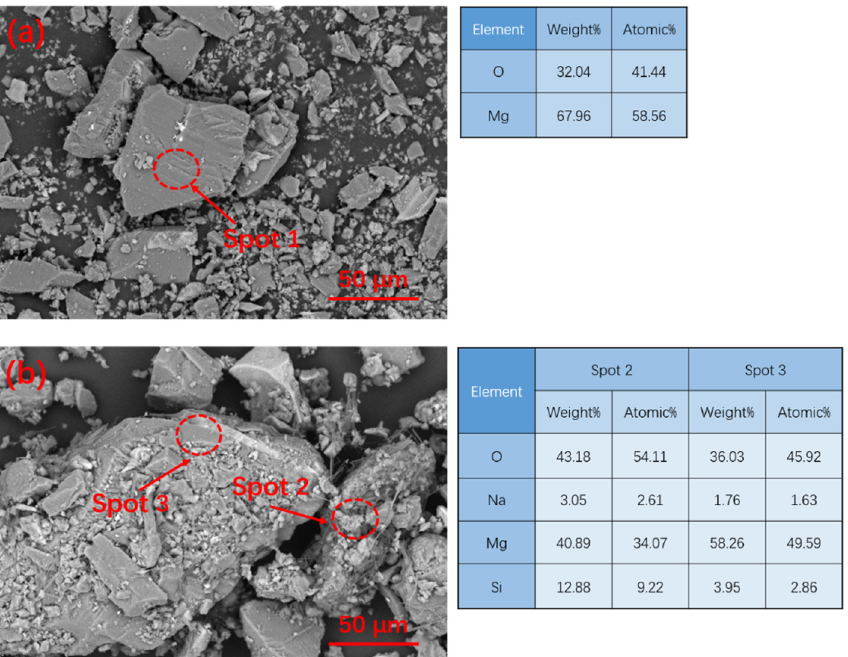
Figure 3. SEM pictures and micro-region composition of MgO before and after modification: ( a ) unmodified MgO; ( b ) modified MgO with 10% water glass.